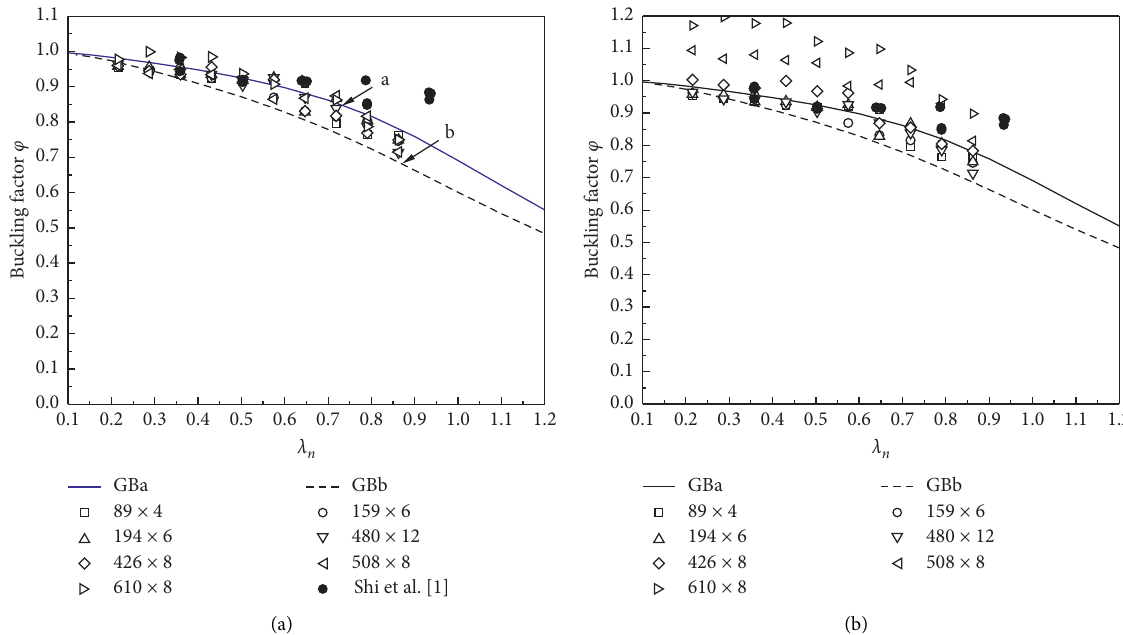
Figure 20: Comparison of FEM results with design curve GB50017-2017. (a) Excluding the local buckling effect with a provision in ASCE48- 05. (b) Excluding the local buckling effect with a provision in